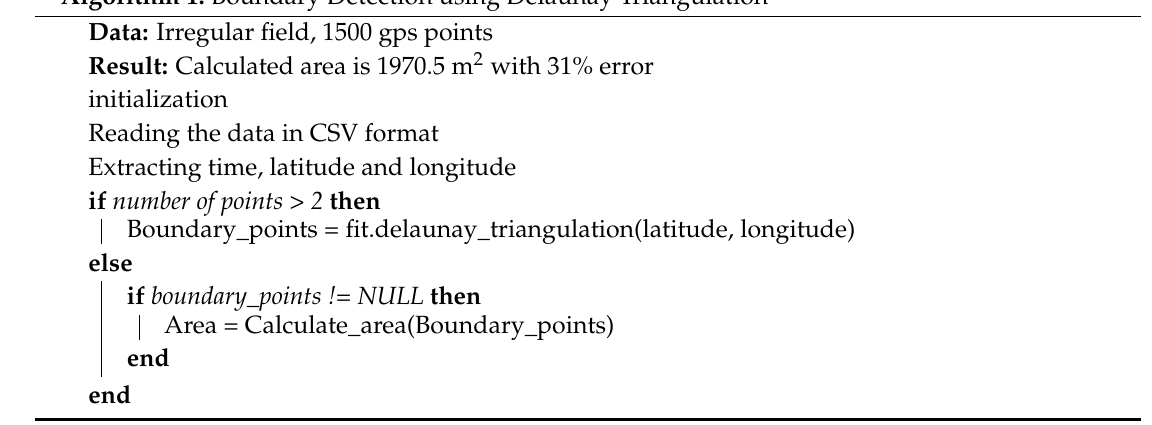
Algorithm 1: Boundary Detection using Delaunay Triangulation Data: Irregular field, 1500 gps